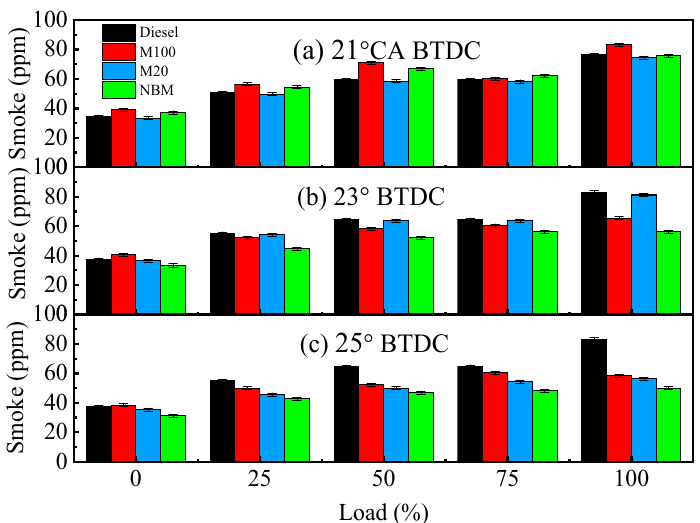
Figure 33. Smoke emission of NBM biodiesel blends and diesel under different loads [257].